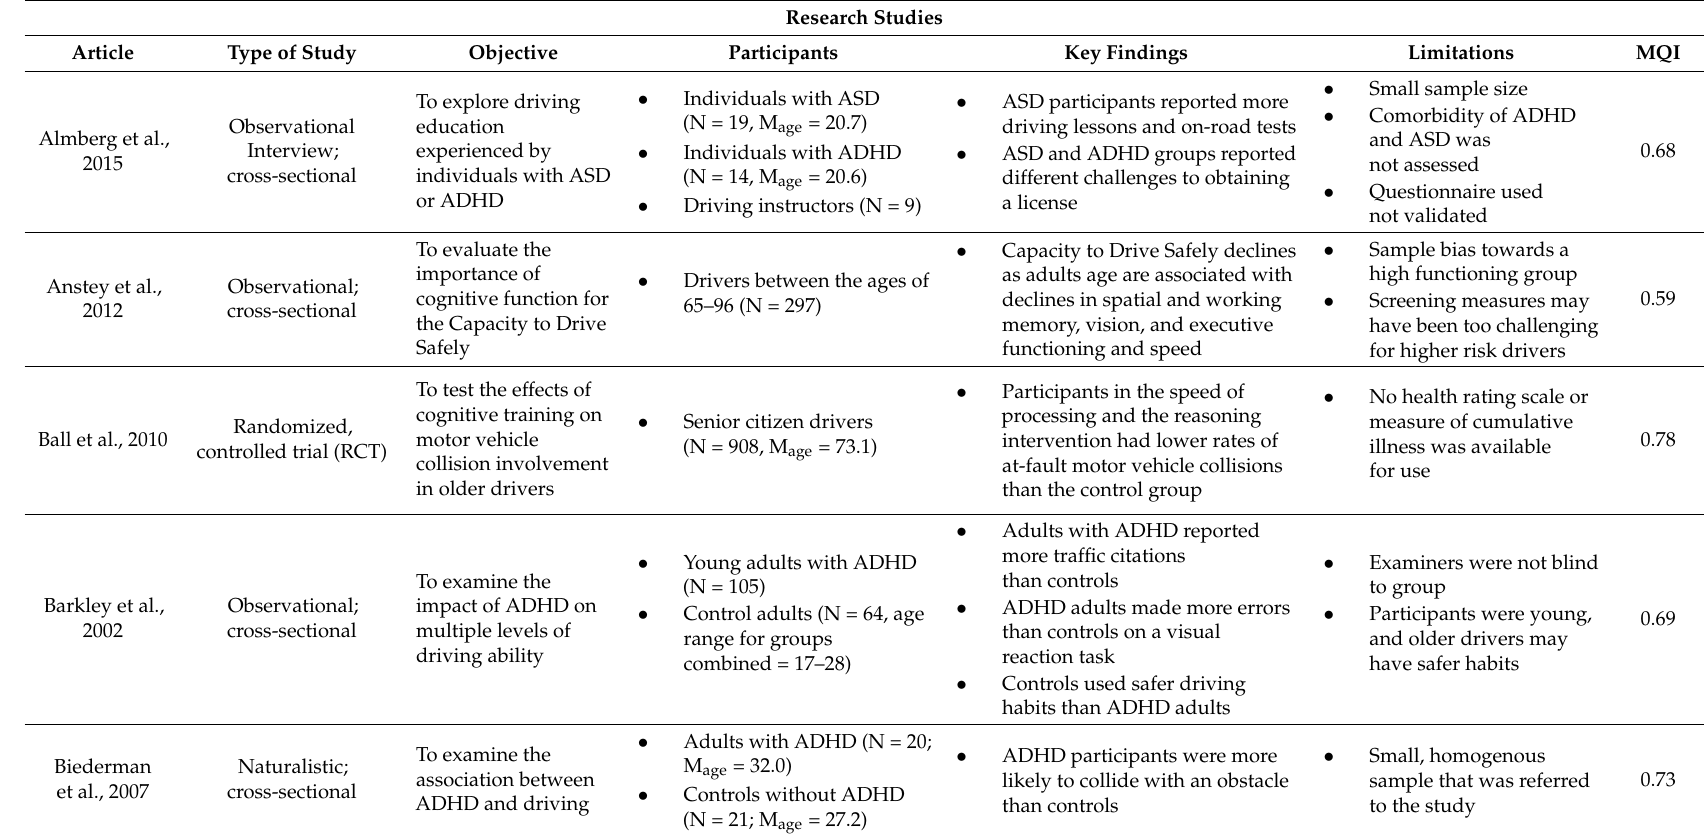
Table 1. Literature Review